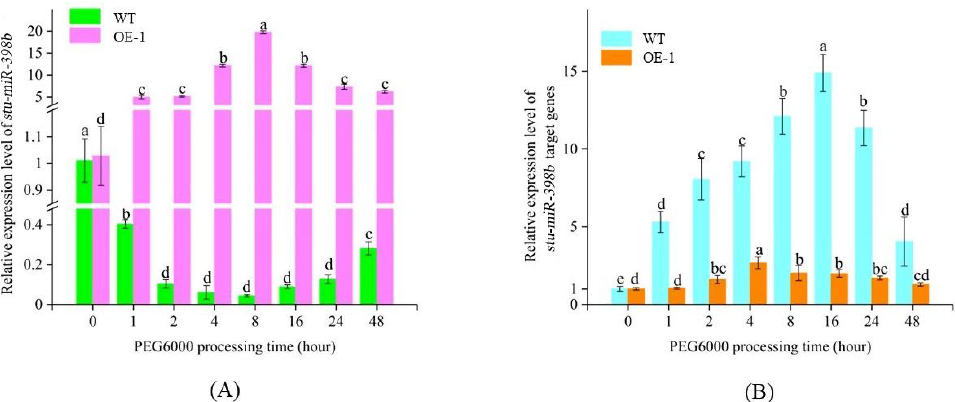
Figure 4. Expression analysis of stu-miR398b-3p and its target genes by qRT-PCR. ( A ) Stu-miR398b-3p expression in OE-1 and WT lines. ( B ) expression of stu-miR398b-3p target genes in OE-1 and WT lines. Three independent biological samples of three technical replicates for qRT-PCR analysis. Each column represents the mean values ± SE ( n = 3). The letters indicate significant difference according to one-way ANOVA corrected by Dunnett ( p < 0.05).